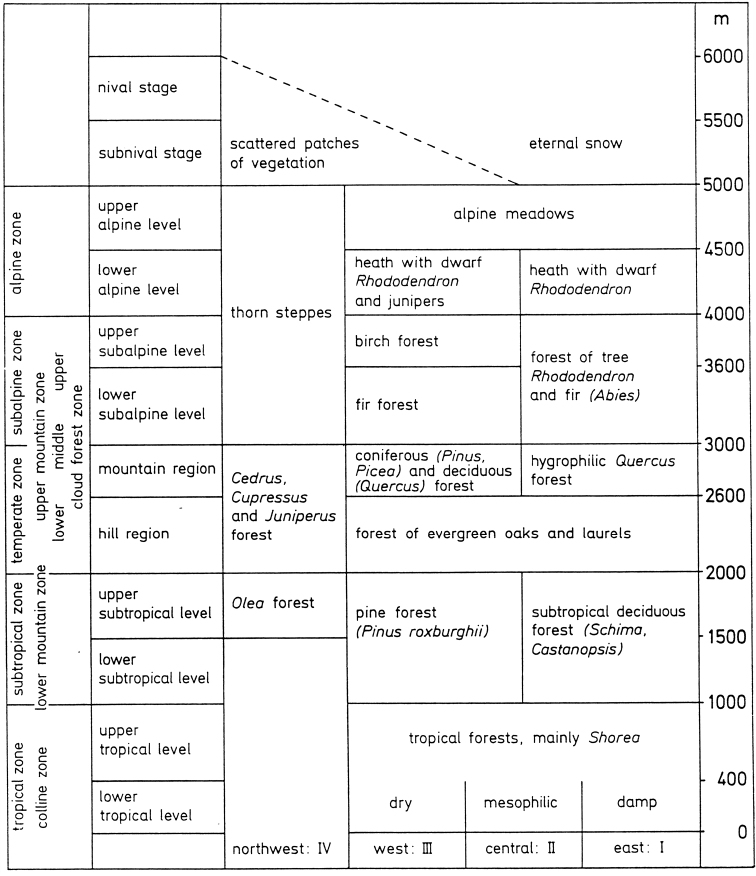
The vegetation belts and most important plant communities in the Nepal Himalayas. The Roman numerals at the bottom indicate the floral regions of Nepal (modified, after Dobremez 1972).